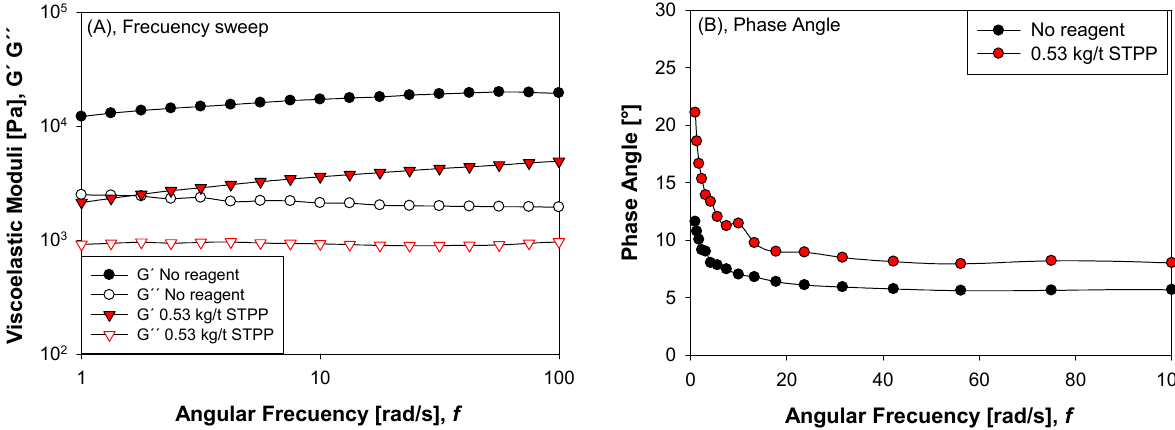
Figure 4. Effect of sodium tripolyphosphate (STPP) on viscoelasticity of kaolin slurries in seawater: ( A ) sweep-frequency test; ( B ) phase angle.